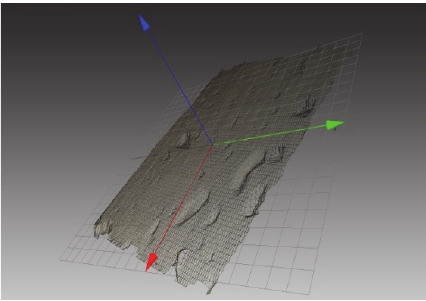
Figure 8: The detected wood specimen.